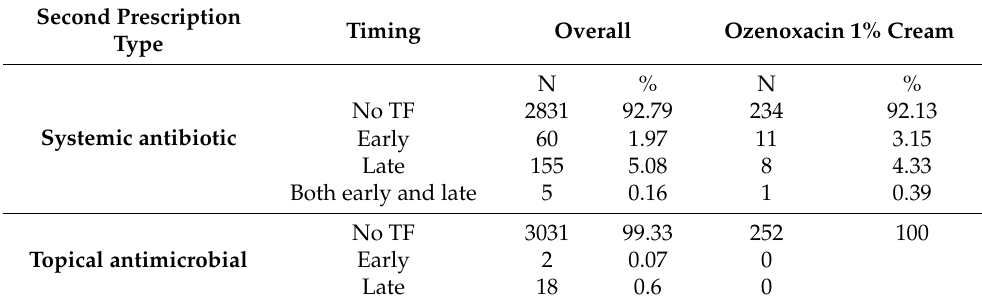
Table 3. Treatment failure (N = 3051 overall cases, N = 256 cases prescribed ozenoxacin). Pedianet,